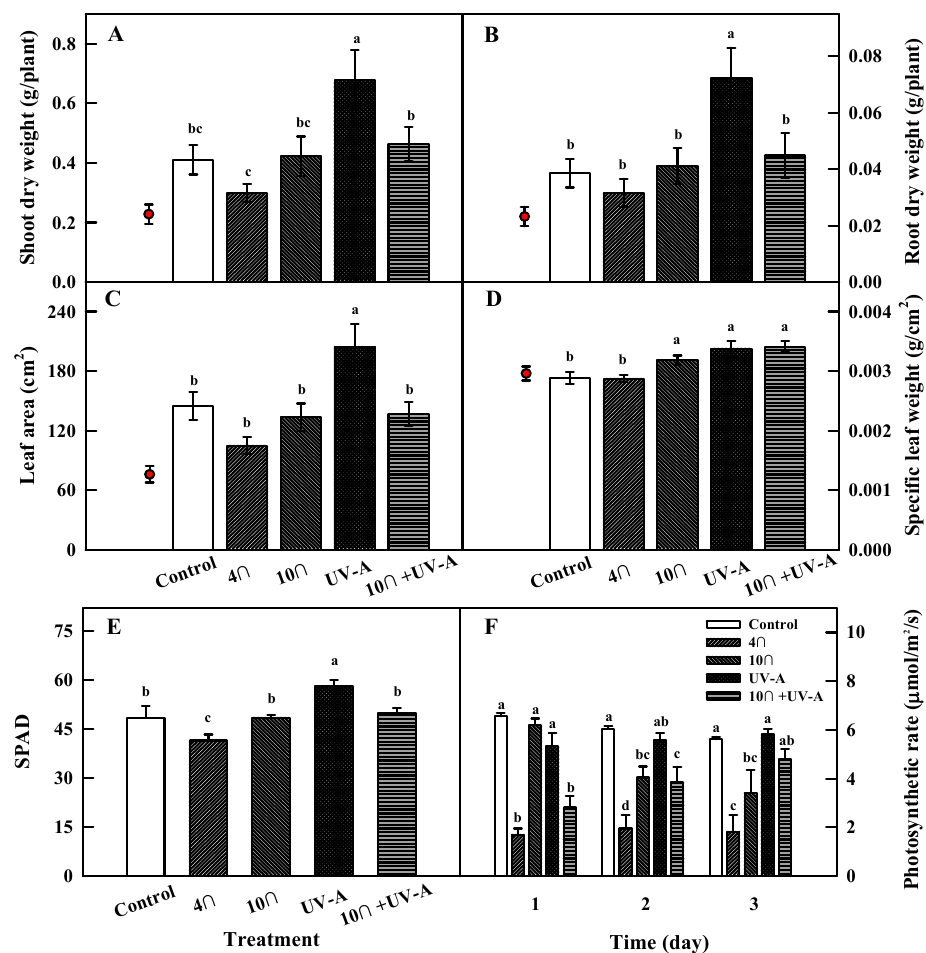
Figure 2. Shoot ( A ) and root ( B ) dry weight, leaf area ( C ), and specific leaf weight ( D ) of kale after 2 days of recovery from stress treatment. Red circles indicate each initial growth parameter immediately before treatment. SPAD value ( E ) of kale at 2 days of recovery and photosynthetic rate ( F ) of kale leaves subjected to chilling, UV-A, and combined treatments at 1 (28 h), 2 (52 h), and 3 days (76 h) of treatment. The vertical bars indicate standard errors ( A , B , C , and D , n = 9; E and F , n = 4). Di ff erent letters above the bars indicate significant di ff erences at p -value < 0.05.